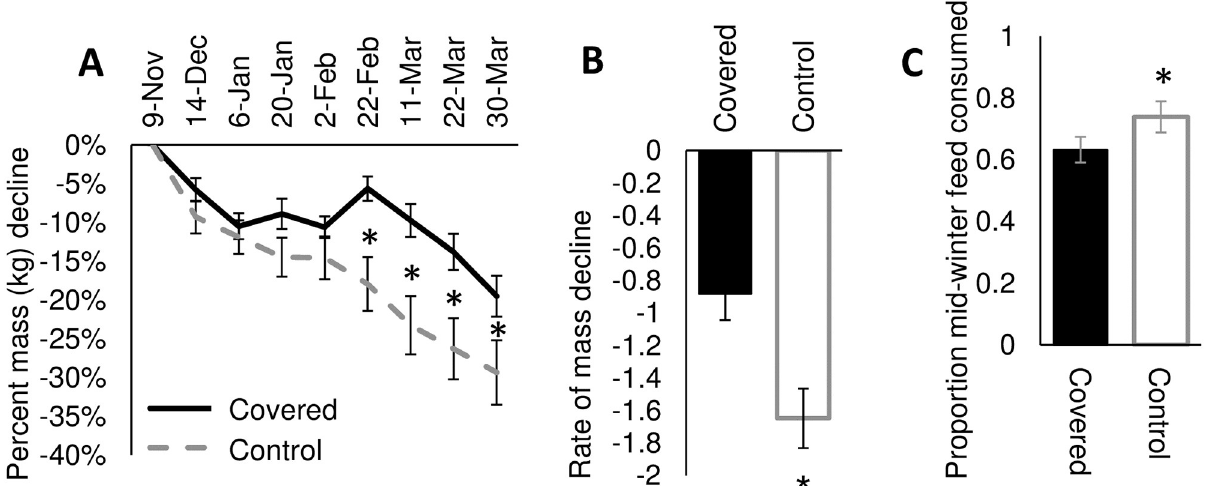
Fig 4. (A) Percent change in mass of colonies by treatment (covered vs control). Percent change is based on the starting mass in kg of colonies on November 9 th , 2020. (B) Mean rate of mass decline (kg mass/sample period) in colonies by treatment. (C) Proportion of mid-winter supplemental granular sugar cake colonies consumed by treatment. Asterisks represent significance at α = 0.05 and error bars are one standard error of the